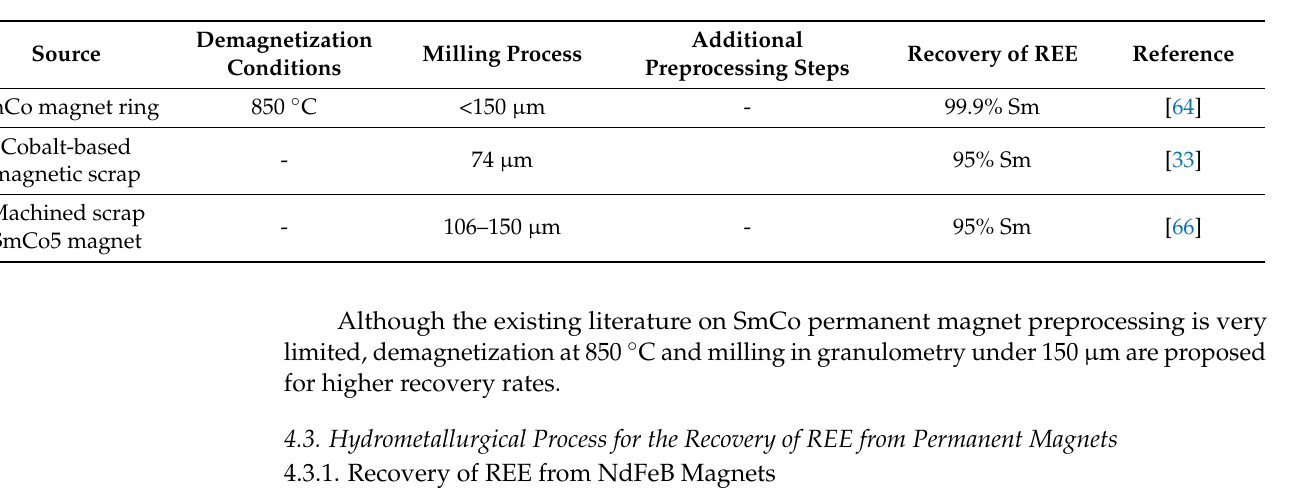
Table 5. Proposed preprocessing of the SmCo permanent magnets.